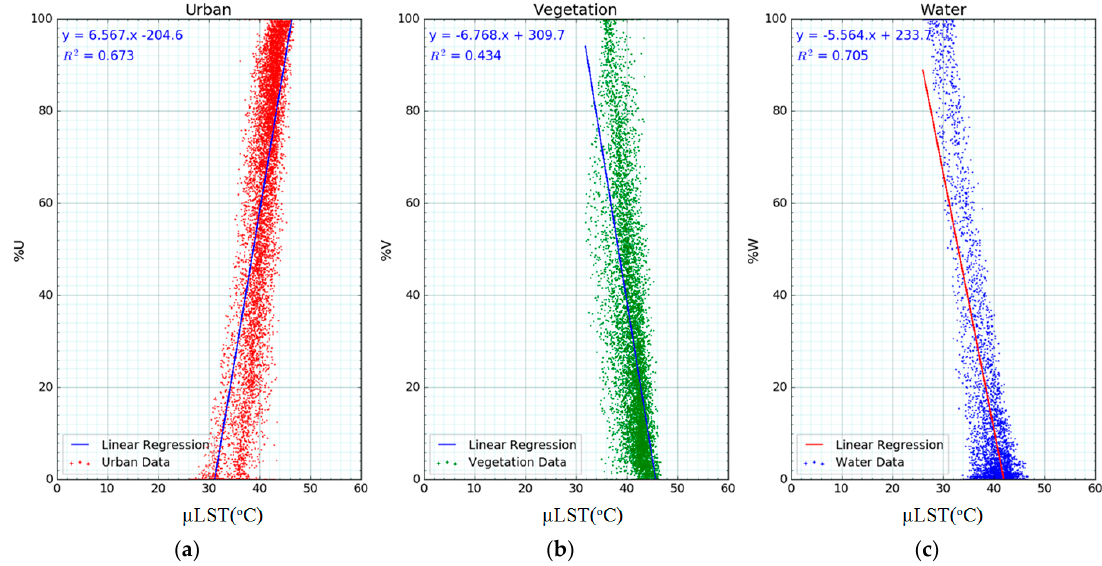
Figure 8. Relationships between percentage coverage of land-use types (%U, %V, and %W) and mean LSTs (µLST) on the hottest day of 2017 (4 June): ( a ) Urban coverage (%U); ( b ) Vegetation coverage (%V); and ( c ) Water coverage (%W) versus µLST.